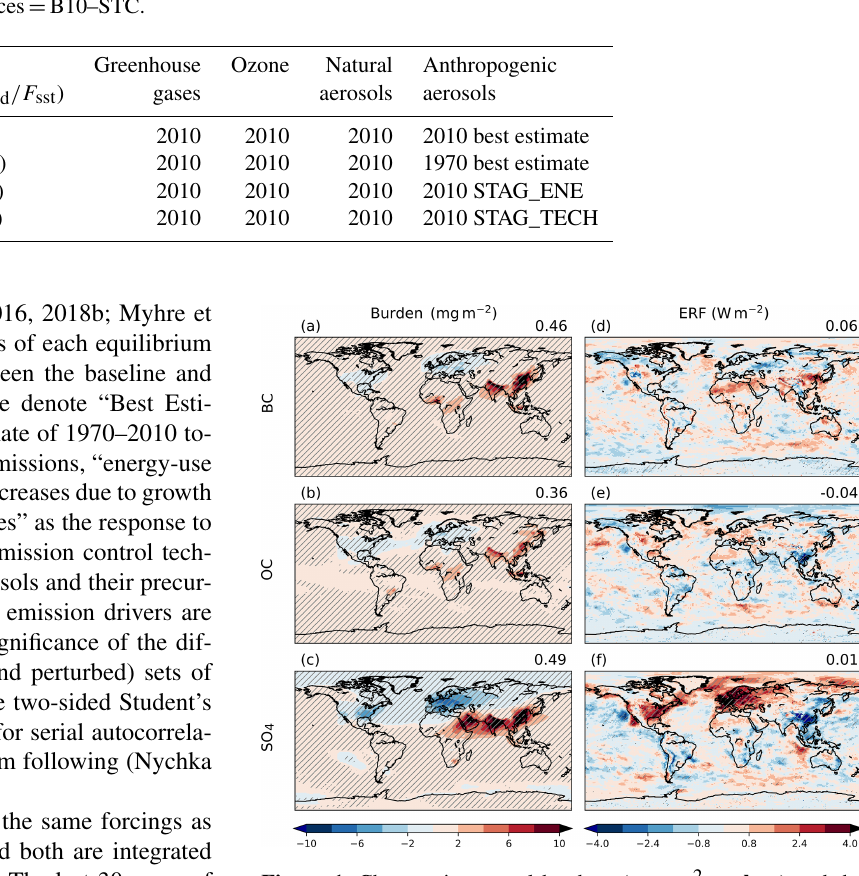
Figure 1. Changes in aerosol burdens (mgm − 2 ; a, b, c ) and the effective radiative forcing (ERF, Wm − 2 ; d, e, f ) associated with the best estimate of 1970–2010 changes in emissions of (a, d) black carbon (BC), (b, e) organic carbon (OC), and (e, f) sulfate species (SO 4 ). The numbers on the top right of each panel are the global means. NB the burden of BC (including the global mean value) is multiplied by a factor of 10 for legibility. The statistical significance at the 5% level is calculated using the two-tailed Student’s t test, and these areas are denoted by the grey